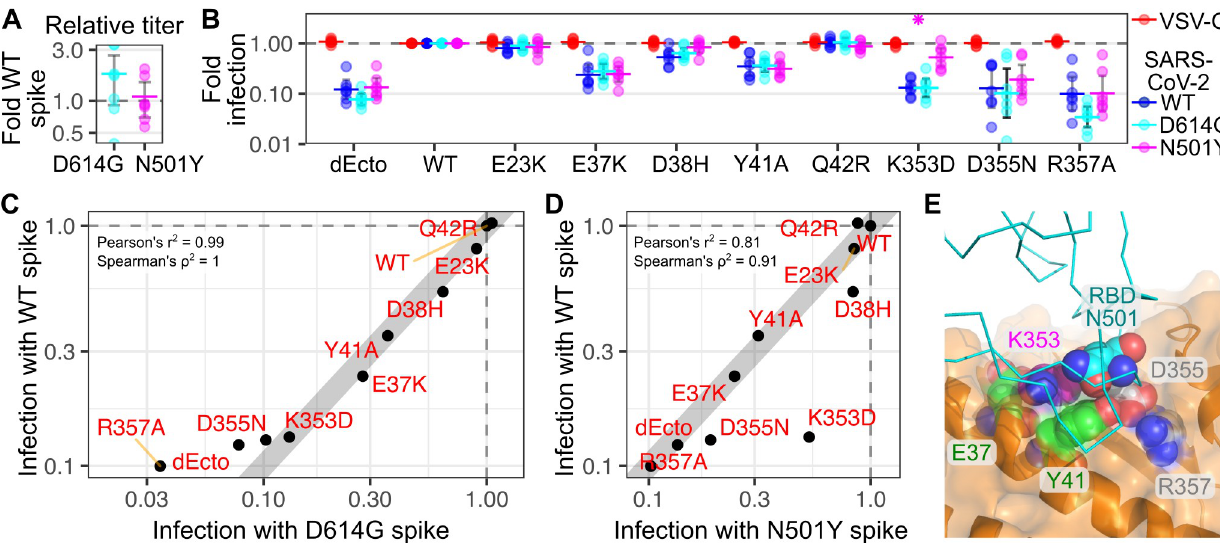
Fig 6. ACE2 variant dependencies for SARS-CoV-2 spike variants. A) Relative titers of D614G and N501Y SARS-CoV-2 spike pseudoviruses, relative to WT. n = 7. B) Relative infectivity of WT, D614G, N501Y SARS-CoV-2 spike pseudoviruses, normalized to infectivity in WT ACE2 cells. VSV-G pseudoviruses were included as a negative control. n = 7. C) Scatter plot showing normalized infectivities of D614G (x-axis) and WT (y-axis) SARS-CoV-2 spike pseudoviruses. D) Scatter plot showing normalized infectivity of N501Y (x-axis) and WT (y-axis) SARS-CoV-2 spike pseudoviruses. The grey line in panels C and D, denote a hypothetical perfect correspondence between assays with a slope of 1. E) Structure of the RBD:ACE2 interface (pdb: 6m17), with the RBD shown as a cyan ribbon, and ACE shown as an orange cartoon with a semi-transparent surface representation. Residues of ACE variants highlighted in Figs 4E and 6D are shown as sphere representations. N501 on the RBD is shown as blue spheres.